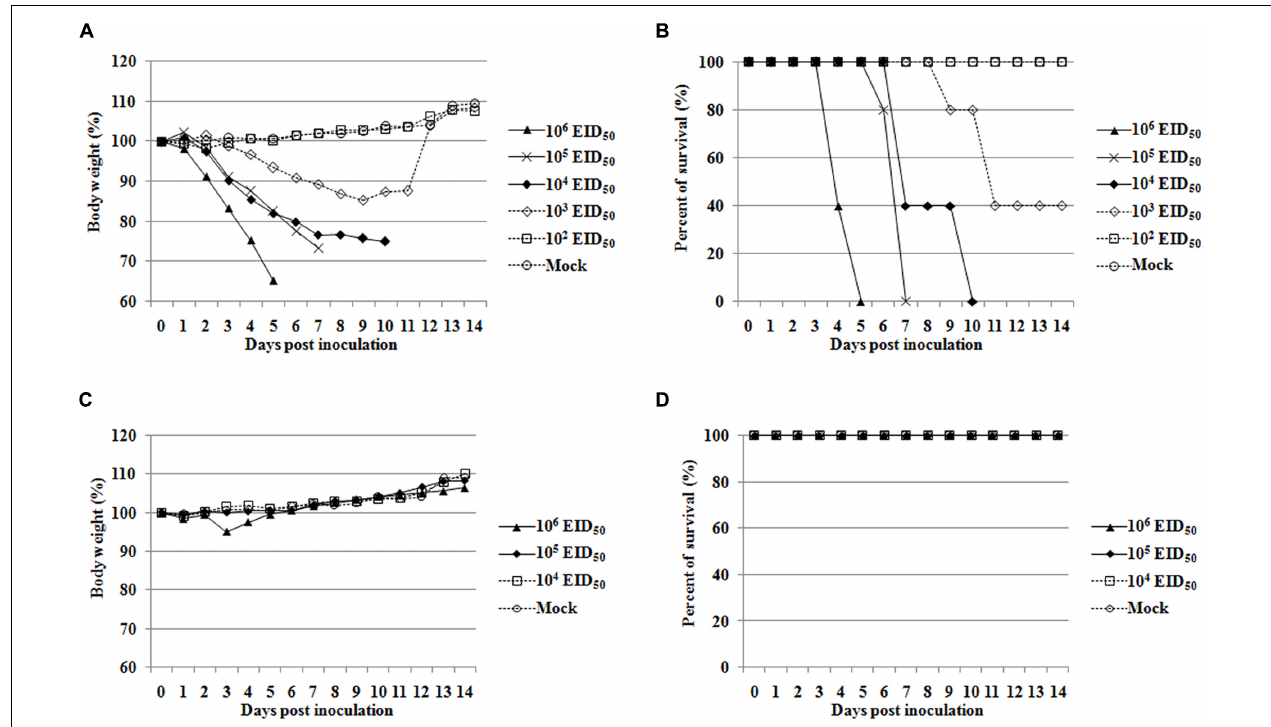
FIGURE 1 | Pathogenicity of NJ06 and NJ01 viruses in mice. Groups of five BALB/c mice were inoculated intranasally with different doses of virus (10 2 –10 6 EID 50 of NJ06 or 10 4 –10 6 EID 50 of NJ01) or mock inoculated (Mock). Morbidity was evaluated by monitoring weight changes over a 14-day period and is graphed as a percentage of the animals’ weight on the day of inoculation (day 0). The average body weight of mice infected with NJ06 (A) or NJ01 (C) is shown. Mortality of NJ06 (B) and NJ01 (D) infected mice was examined by measuring the percent